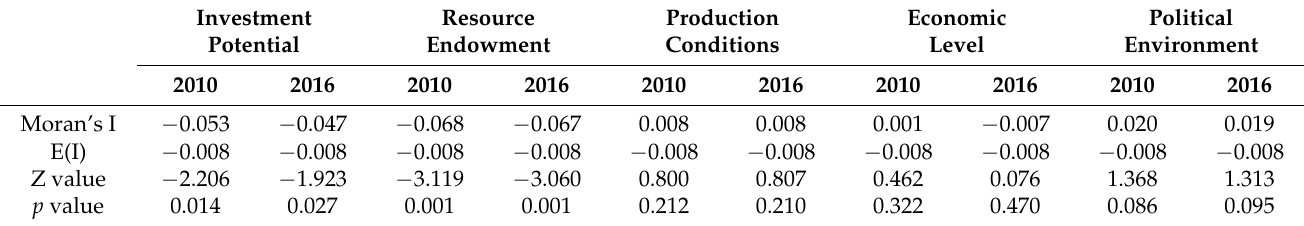
Table 6. Moran’s I index test of cultivated land investment potential index of countries along “the belt and road initiative". Investment Resource Production Potential Endowment